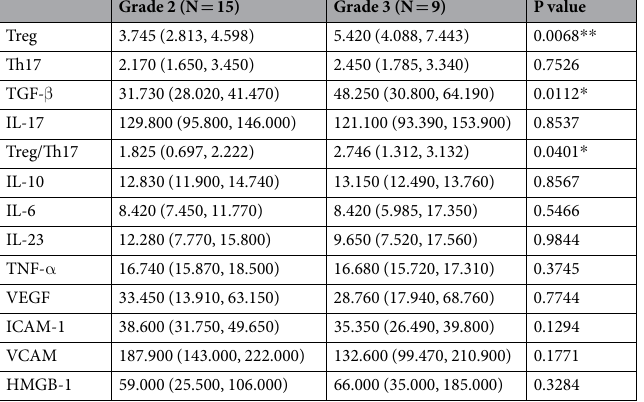
Table 4. Correlations between Treg/Th17 and relevant cytokines and the Suzuki’s angiographic stage. Notes: Correlation is significant at the 0.05 level. * P < 0.05, ** P < 0.01.